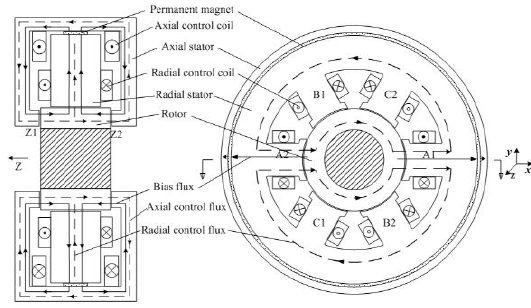
Figure 7. Structure and flux path of six-pole radial-axial hybrid magnetic bearings (HMB).